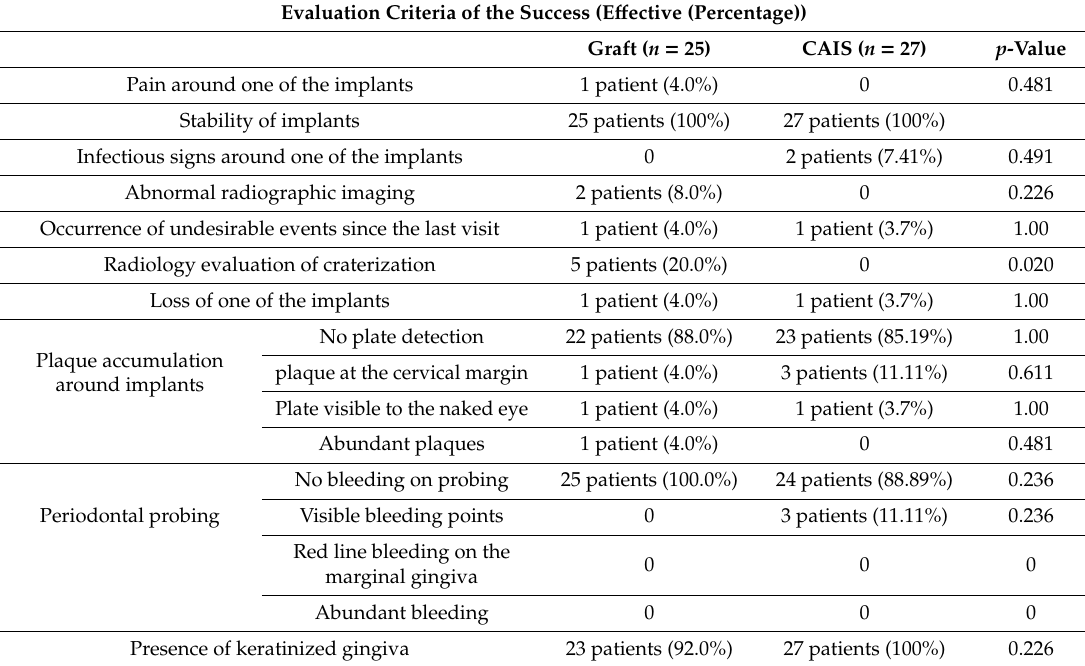
Table 8. Evaluation criteria of the